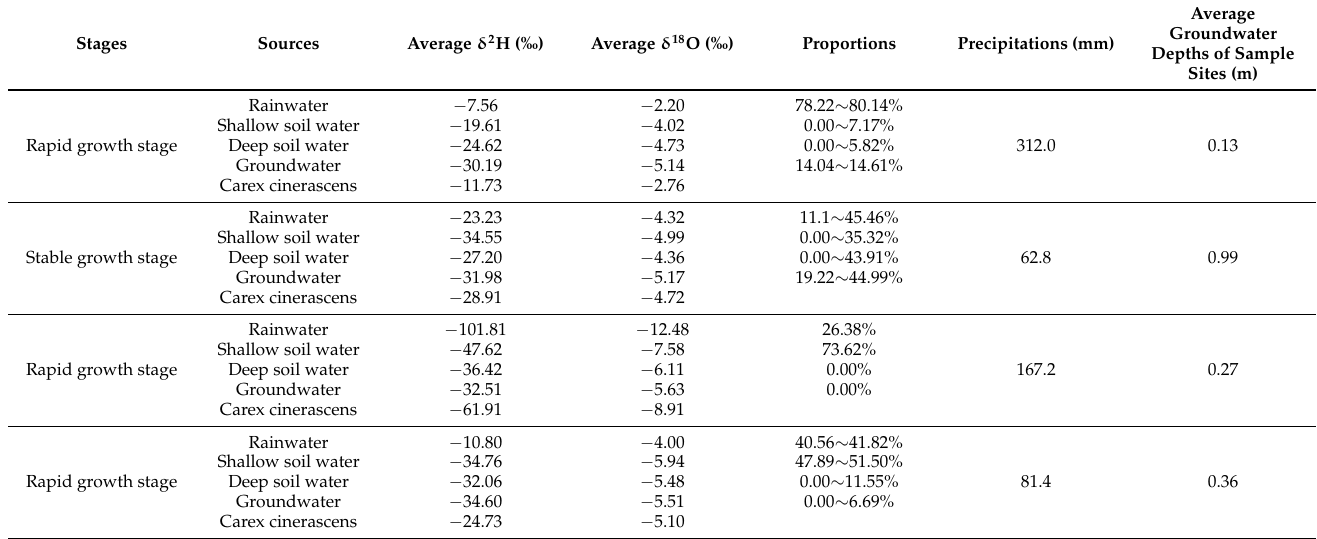
Table 3. Proportions of potential water sources of Carex cinerascens stem